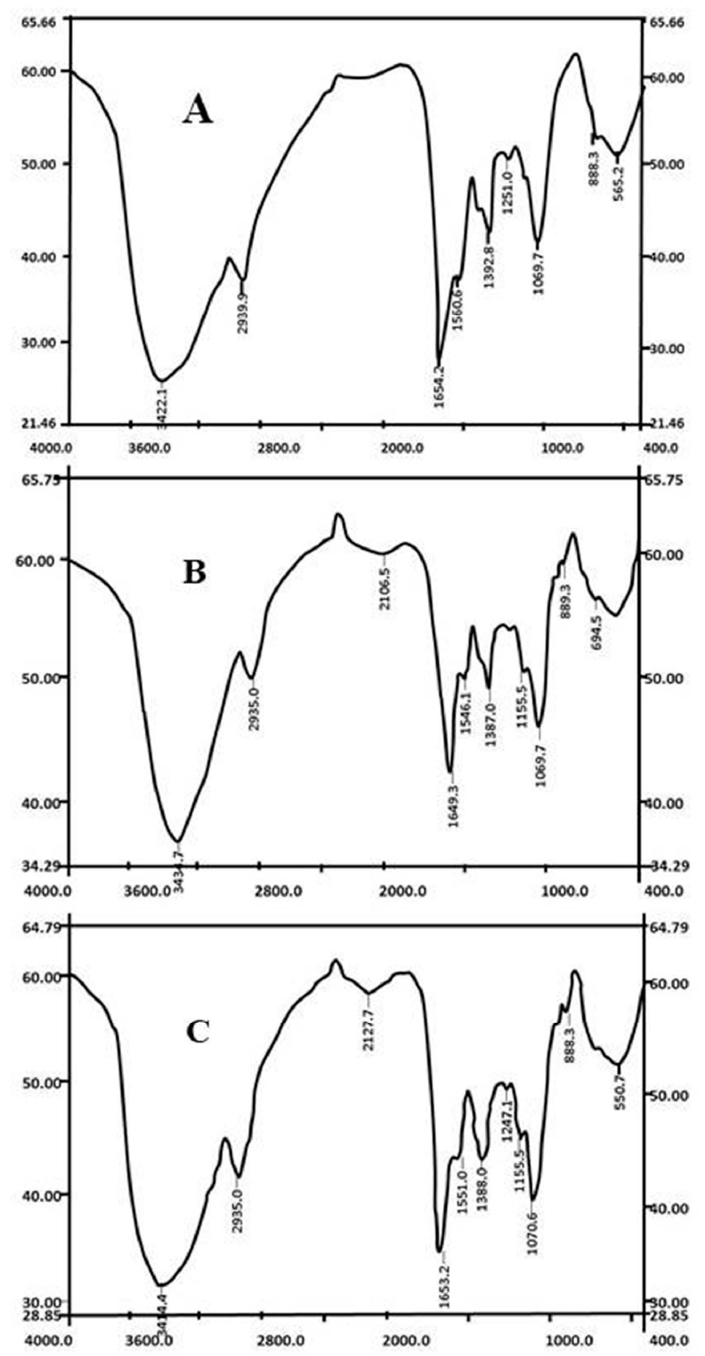
Figure 2. IR spectrogram of Priestia megaterium PRJNA526404 before abosorbing ( A ) and after the absorbing of Zn 2+ ( B ) and Cd 2+ ( C ).